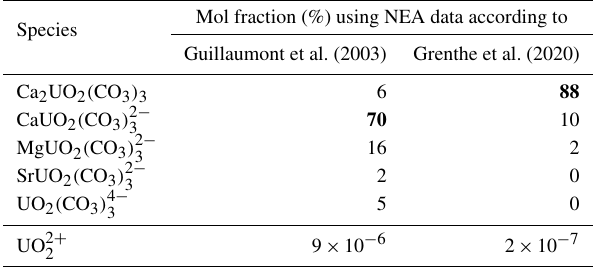
Table 1. The aqueous species distribution changes from predomi- nantly anionic to neutral ternary complexes with the application of the second NEA update for thermodynamic data of uranium (Gren- the et al., 2020) compared to the values published in Hennig and Kühn (2021a) using the data of the first NEA update (Guillaumont et al., 2003). Mol fraction (%) of main uranium species are exem- plarily given for the pore water composition of the shaly facies and the predominant species is printed